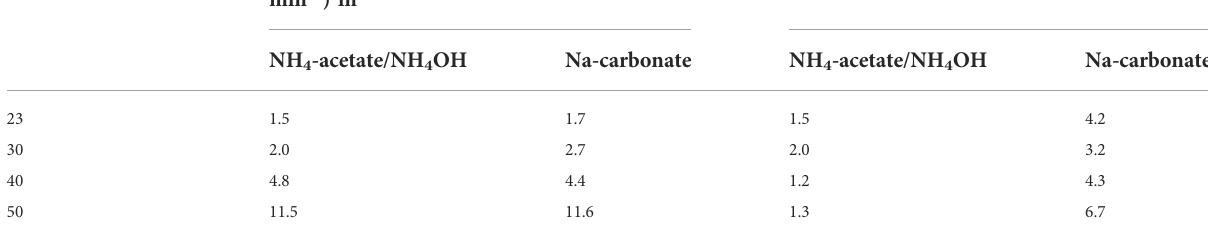
TABLE 1 Rates for the formation of PGN and amounts of PGAA formed in different buffer systems (at pH 9.5) and at different temperatures. Maximal amounts of PGAA (mM) Temperature ( ° C) Rates for the Initial formation of PGN (mM × min − 1 ) in